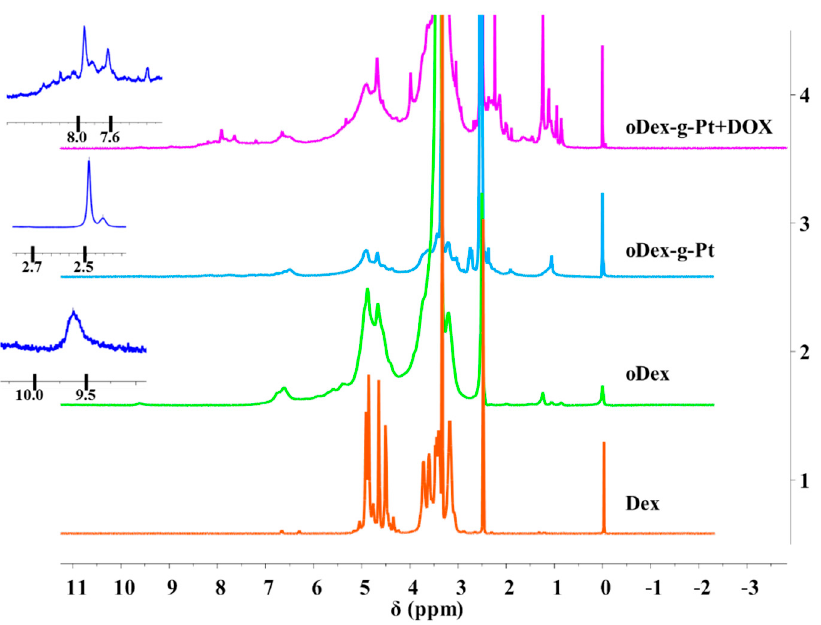
Figure 1. The 1 H NMR spectra of Dex (dextran), oDex (oxidized dextran), oDex-g-Pt (platinum conjugated oxidized dextran), and oDex-g-Pt+DOX (platinum plus DOX conjugated oxidized dex- tran) in DMSO-d 6